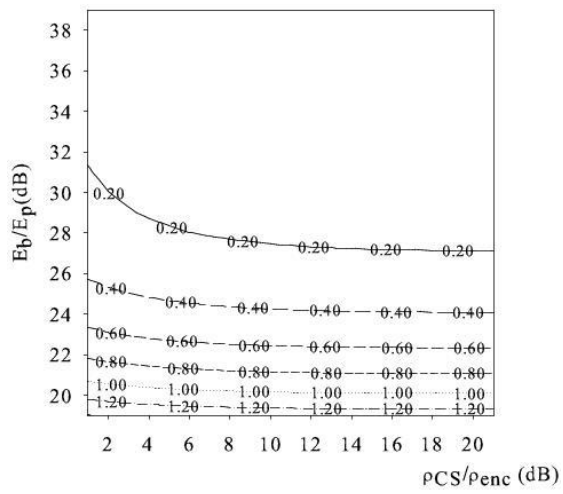
Figure 3. Ratio R in = E in-net / E off-net versus the ratio ρ CS / ρ enc and E b / E p ( N = 32 × 32, L = 8).